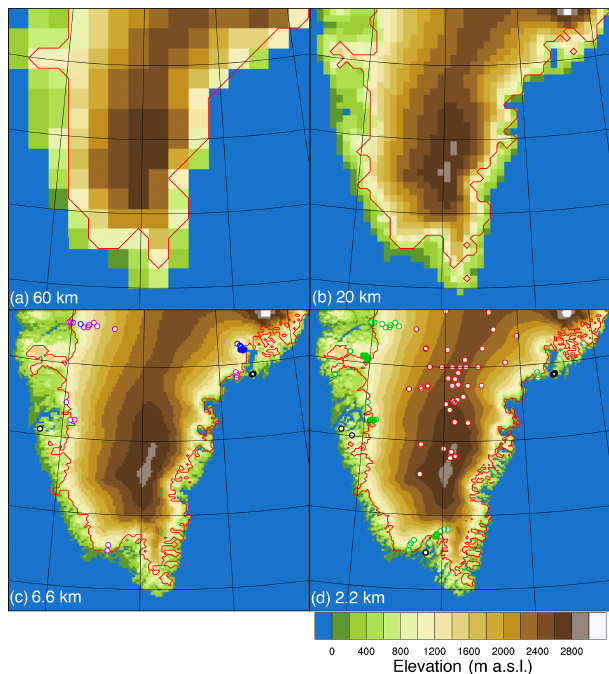
Figure 1. Model elevation and outline of glaciated areas (red) in the shared part of the domain for the four different model resolutions. In (c) , locations of the excluded (black), single year (magenta), and summer (blue) time matched observations are drawn. In (d) , loca- tions of excluded (black) and multi-year ablation (green) and multi- year accumulation (red) observations are